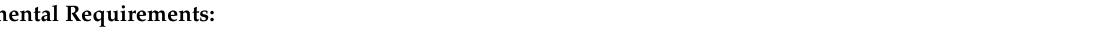
Table 5. Environmental